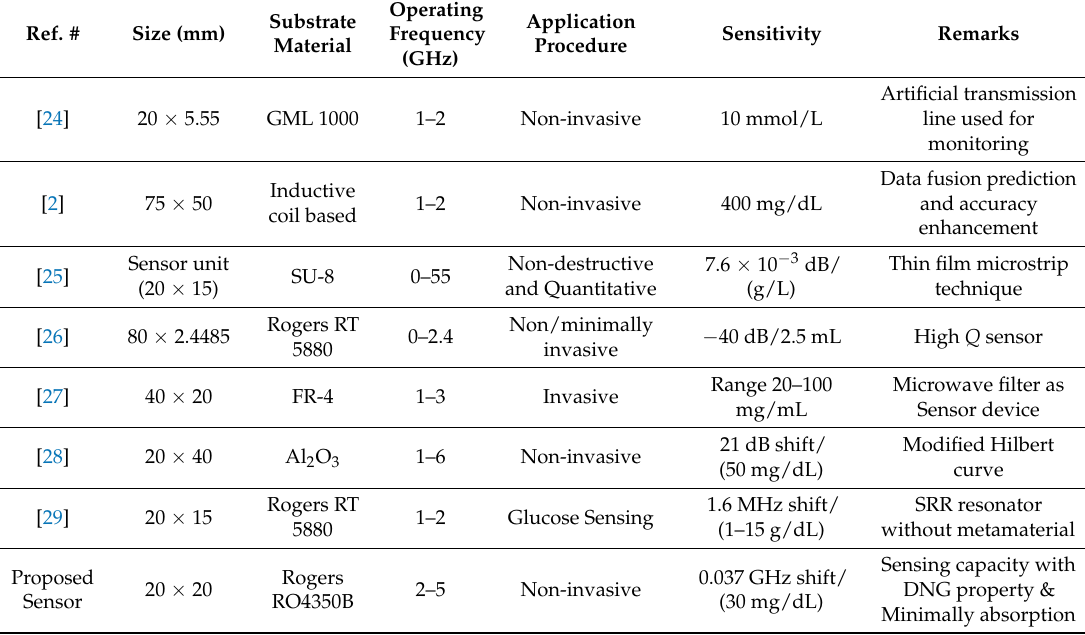
Table 3. A comparative study of glucose sensors with the proposed design.